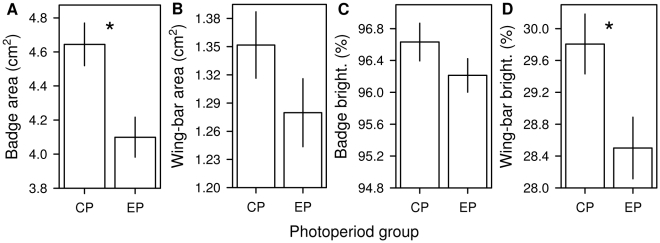
The effect of experimental photoperiod manipulation on plumage ornament expression.Panels show the differences in (A) badge size, (B) wing-bar size, (C) badge brightness and (D) wing-bar brightness between sparrows with experimentally accelerated molting (‘EP’ photoperiod group) and those molting at a natural rate (‘CP’ photoperiod group). Asterisks denote significant differences. Mean ± SE are shown.